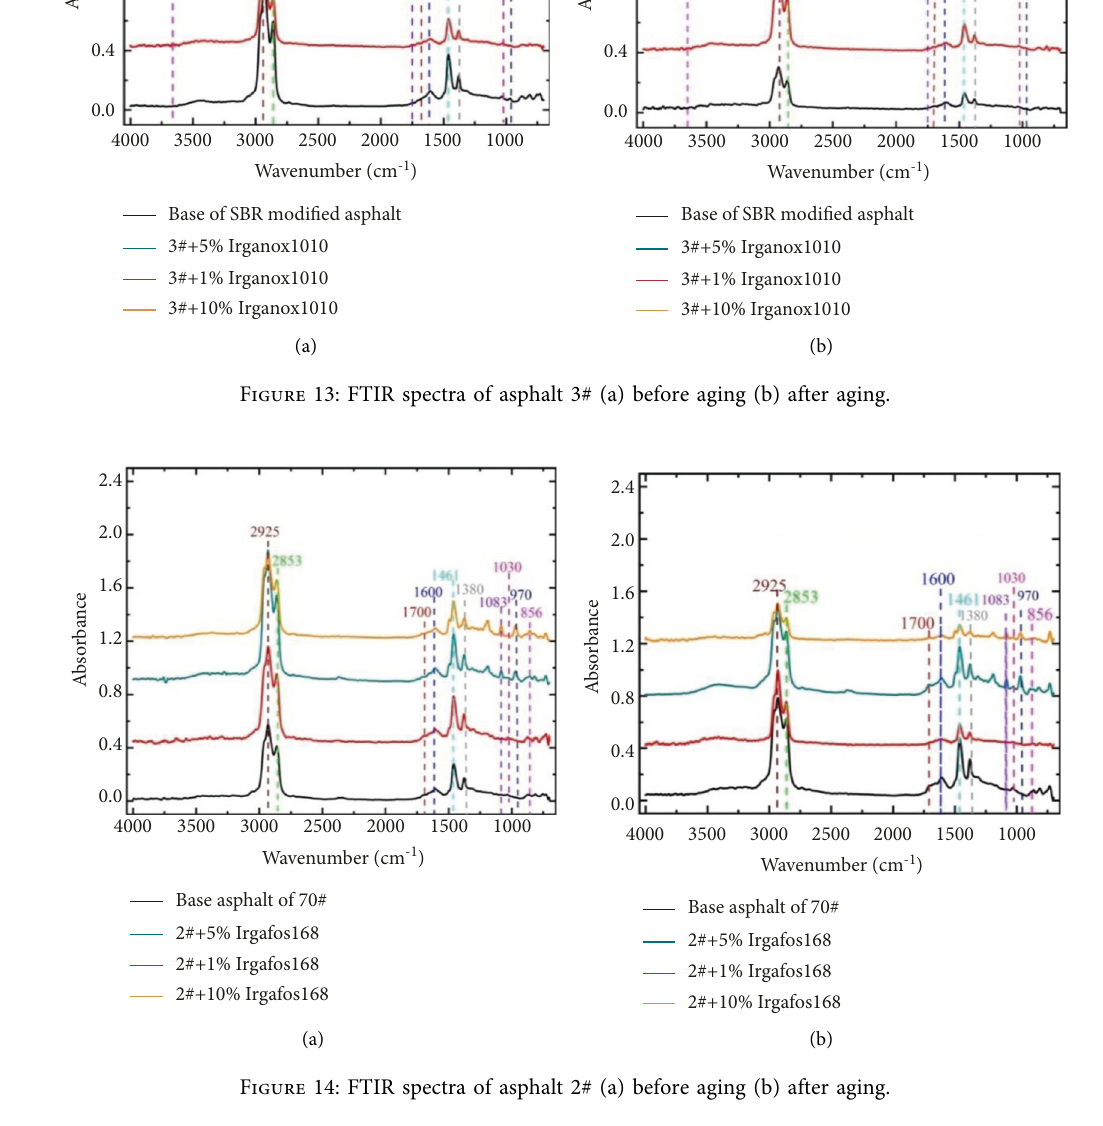
Figure 14: FTIR spectra of asphalt 2# (a) before aging (b) after